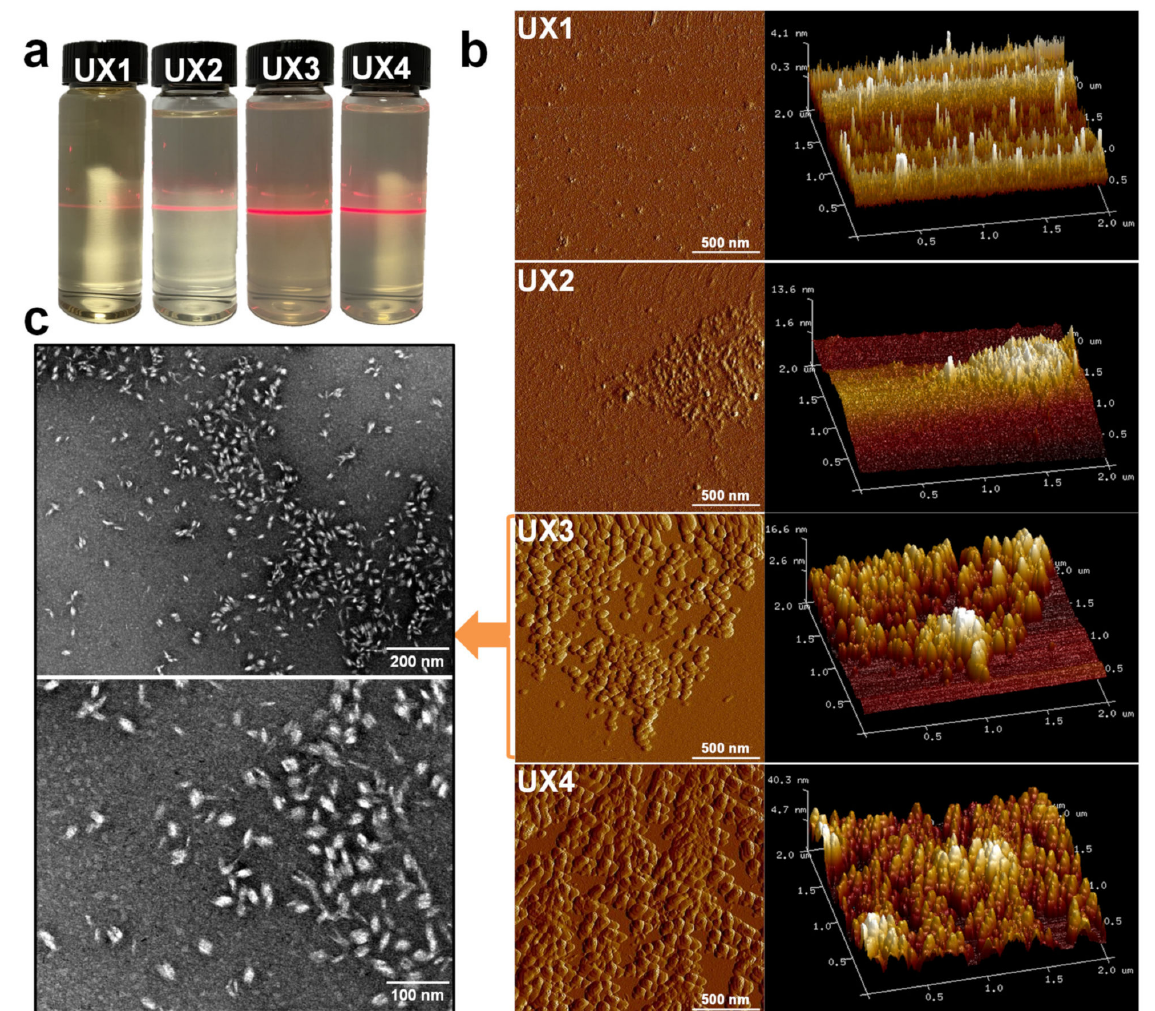
Figure 2. ( a ) Tyndall phenomenon, ( b ) AFM images, and ( c ) TEM images of xylan colloidal dispersions.